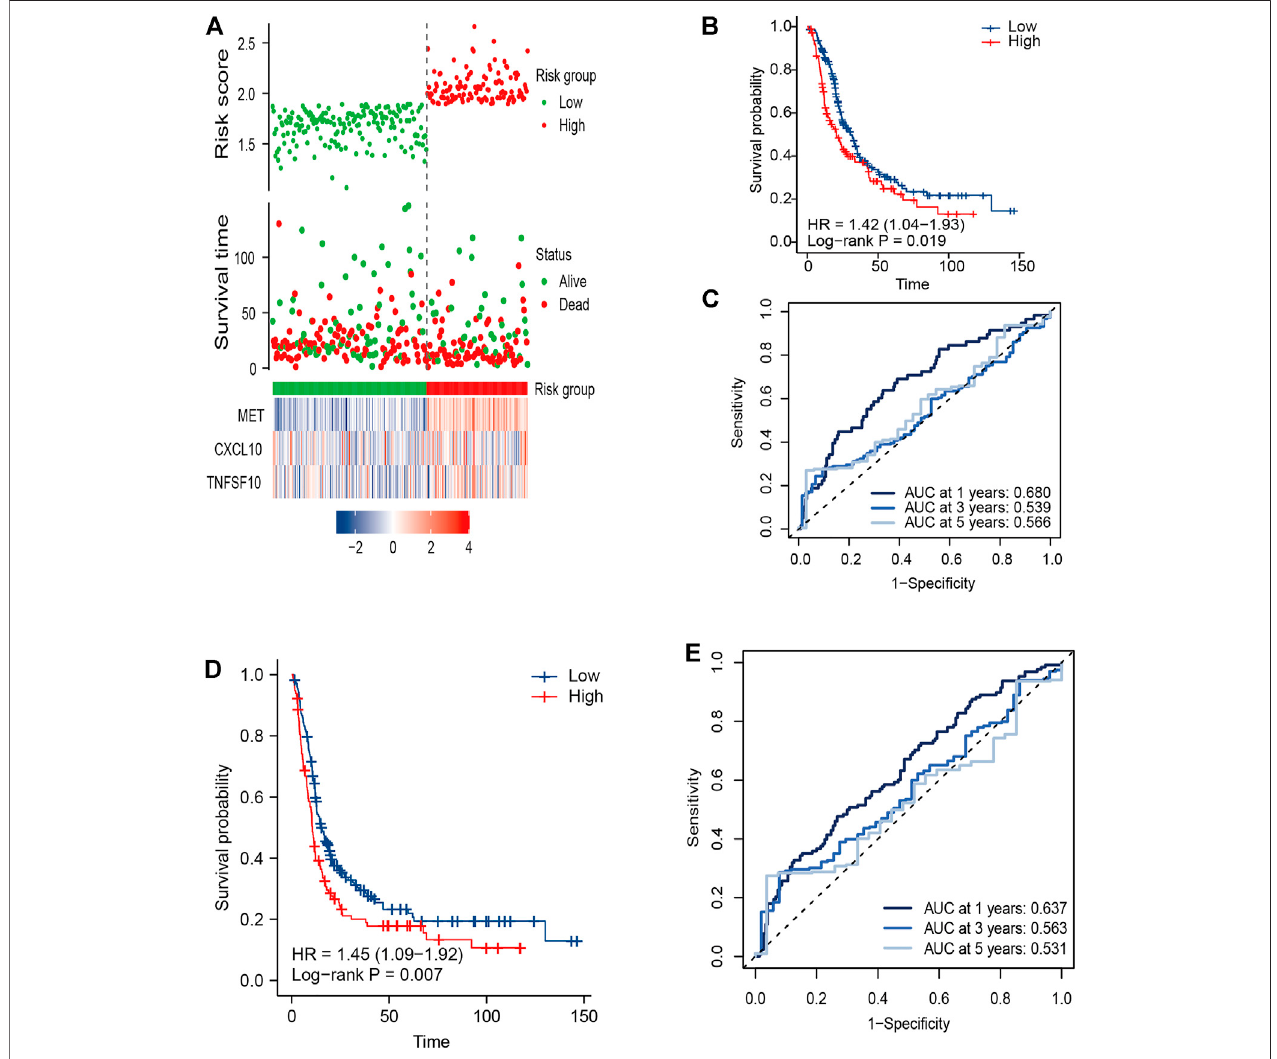
FIGURE 3 | External validation of the three-gene signature in the E-MTAB cohort. (A) Distribution of the risk score, related survival status, and heatmap in the E-MTAB cohort. (B,D) KM survival curves for (B) OS and (D) DFS in the E-MTAB cohort. (C,E) Time ROC curves for forecasting 1-, 3-, and 5-year (C) OS and (E)